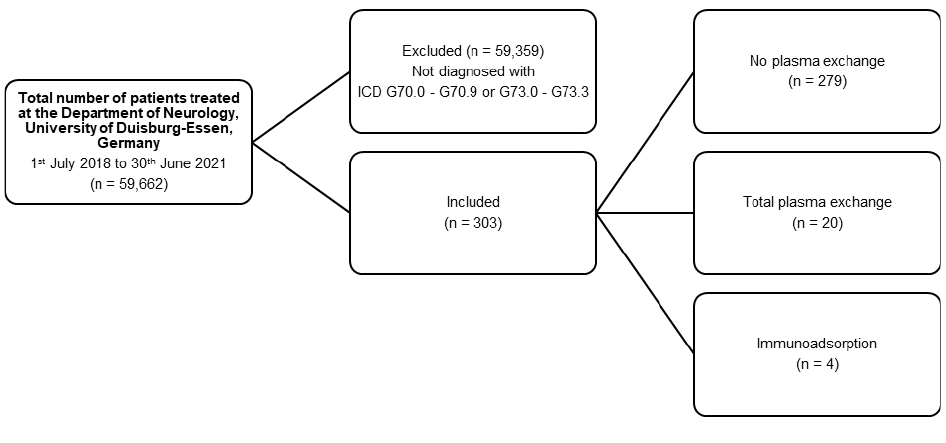
Figure 1. Flow diagram of the retrospective analysis. Table 1. Demographics and ICD codes of patients presenting with neuromuscular junction disorders (n = 303).